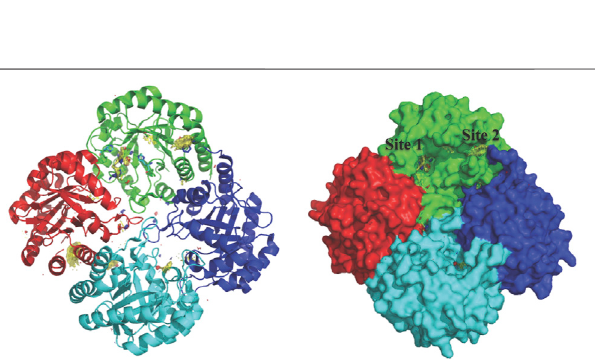
FIGURE11| TetramericstructureofPaKdsAandbindingsites/hotspots identi fi ed by HOTSPOT. Two sites, site A and B have been identi fi ed to which fragments are predicted to